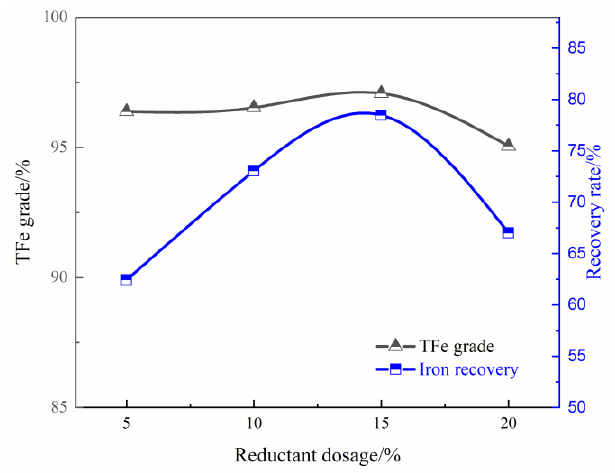
Figure 11. Effects of reductant dosage on the smelting separation of pre-reduced pellets. (Smelting at 1625 °C for 30 min, under natural basicity). (The yields of pig iron obtained at different reductant doses were 26.03%, 26.96%, 32.48%, and 28.17%, respectively).